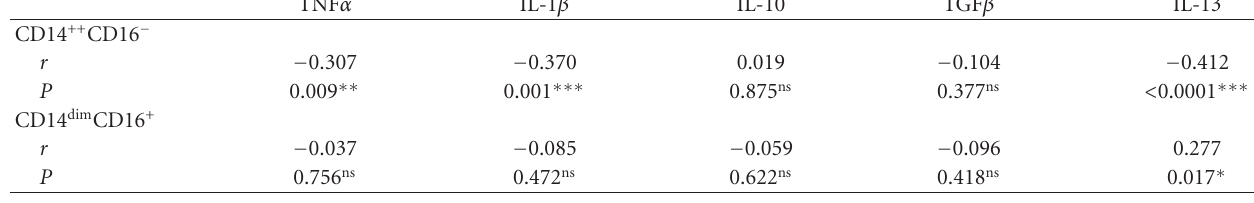
Table 5: Correlation between the CD14 dim CD16 + and CD14 ++ CD16 − monocytic subsets and serum cytokines in controls and HF patients.